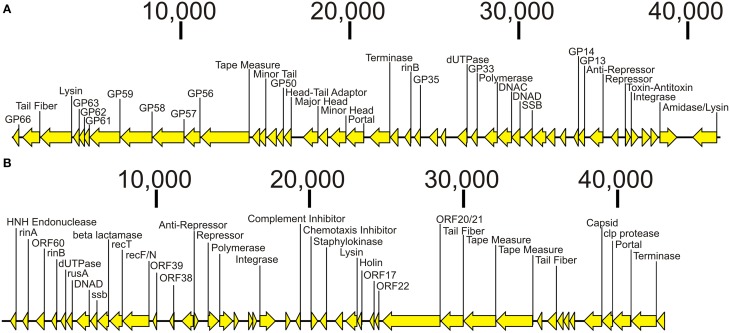
Diagram of bacteriophage genomes sequenced from the virions from Subjects 3MRA (A) and 23MRA (B). Putative ORFs and their direction are indicated by the arrows. ORFs that had significant homologs (BLASTP E-score <10−5) are indicated by the text above each arrow. In (A), those ORFs that had synteny with Staphylococcus phage PhiETA2 are labeled GP66, GP63, GP62, GP61, GP59, GP58, GP57, GP56, GP50, GP35, GP33, GP14, and GP13. In (B), those ORFs that had synteny with Staphylococcus phage PhiPVL are labeled ORF60, ORF39, ORF38, ORF22, ORF21, ORF22, and ORF17. Putative functions for each ORF are labeled when available. The length of each contig is denoted at the top of each panel.